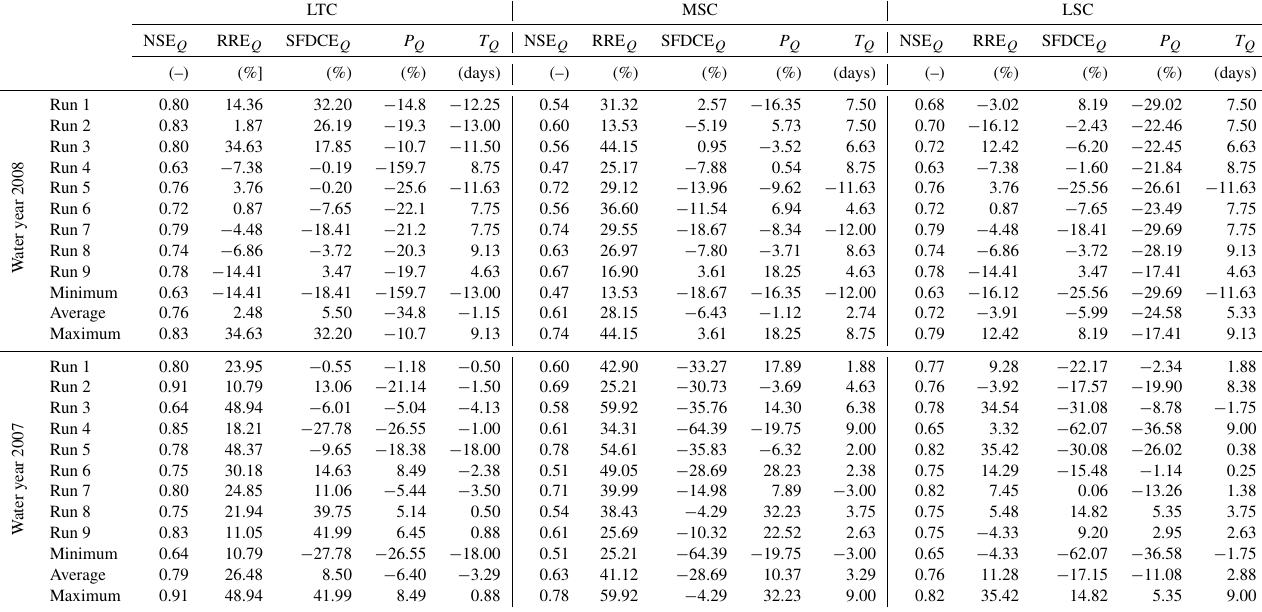
Table B1. Error metrics for the nine behavioral sets. Metric abbreviations correspond to metrics shown in Table 2 and Figs. 3 and